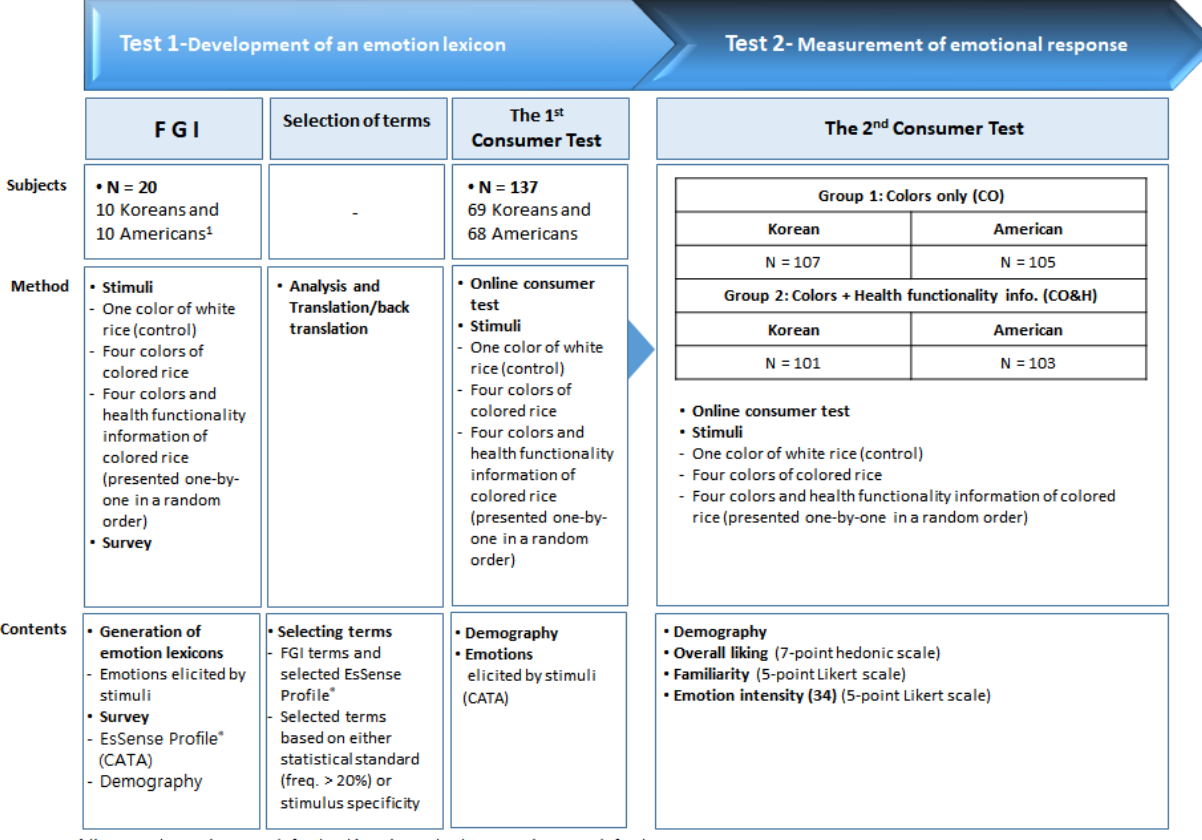
Figure 1. Process and methods of the study.